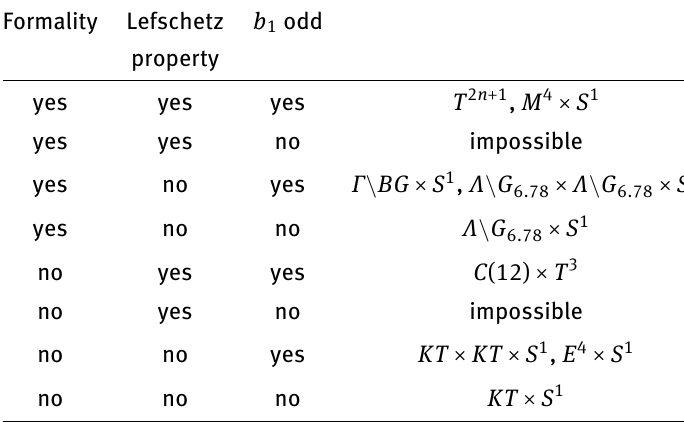
Table 3: Product K-cosymplectic manifolds with arbitrary b